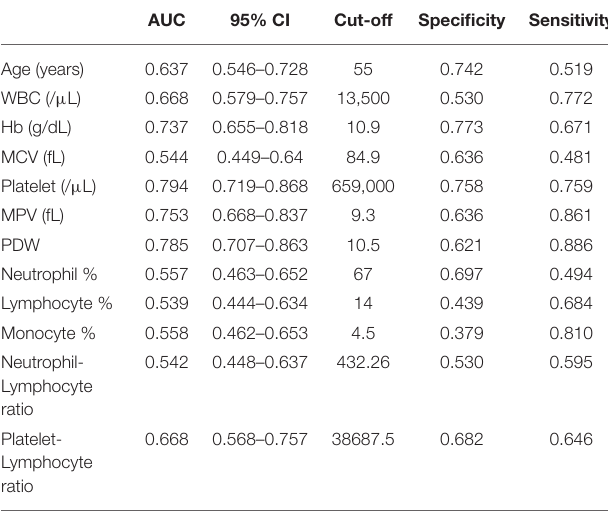
TABLE 2 | Results of ROC curve analysis for each positive risk factor.